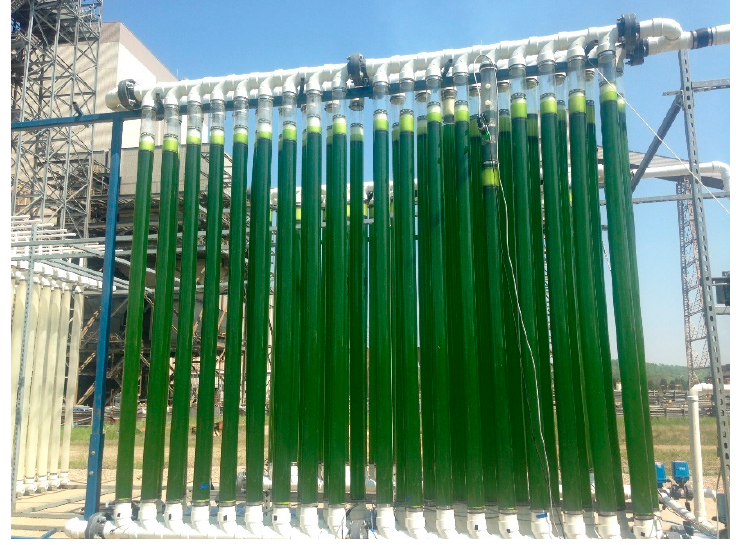
Figure 1. Cyclic flow photobioreactor (PBR) deployed at East Bend Station power plant.